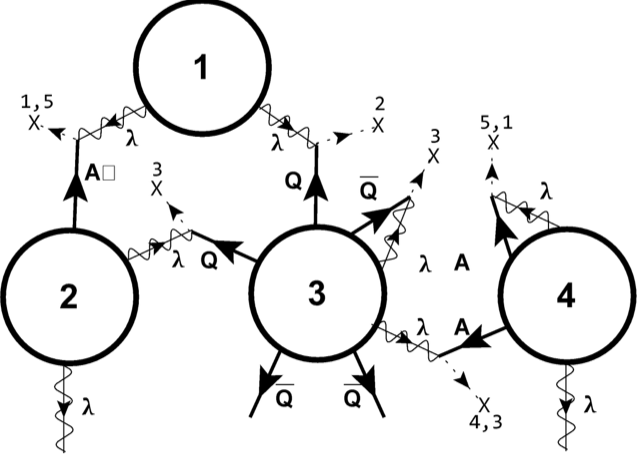
Figure 13: A sketch of multi-monopole composite with + 2 + 3 when M ≫ B are large. The gauge group breaks from SU ( 5 ) to SU ( 2 ) . Only one of the “resonance" diagrams is shown. The anti-symmetric and squark VEVs, (C.3) and (C.4), are rep- resented as X with their indices. A □ represents the components of anti-symmetric tensor which transform as a fundamental representation under SU ( 4 )